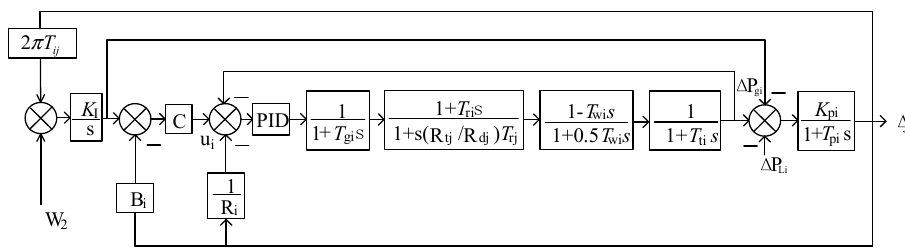
Figure 4. Frequency control system model of DFPSU. Table 2. Variable